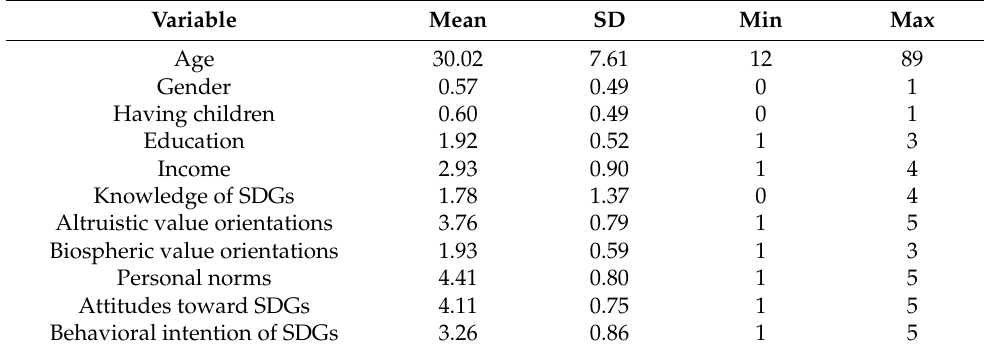
Table 1. Descriptive statistics for variables (n =